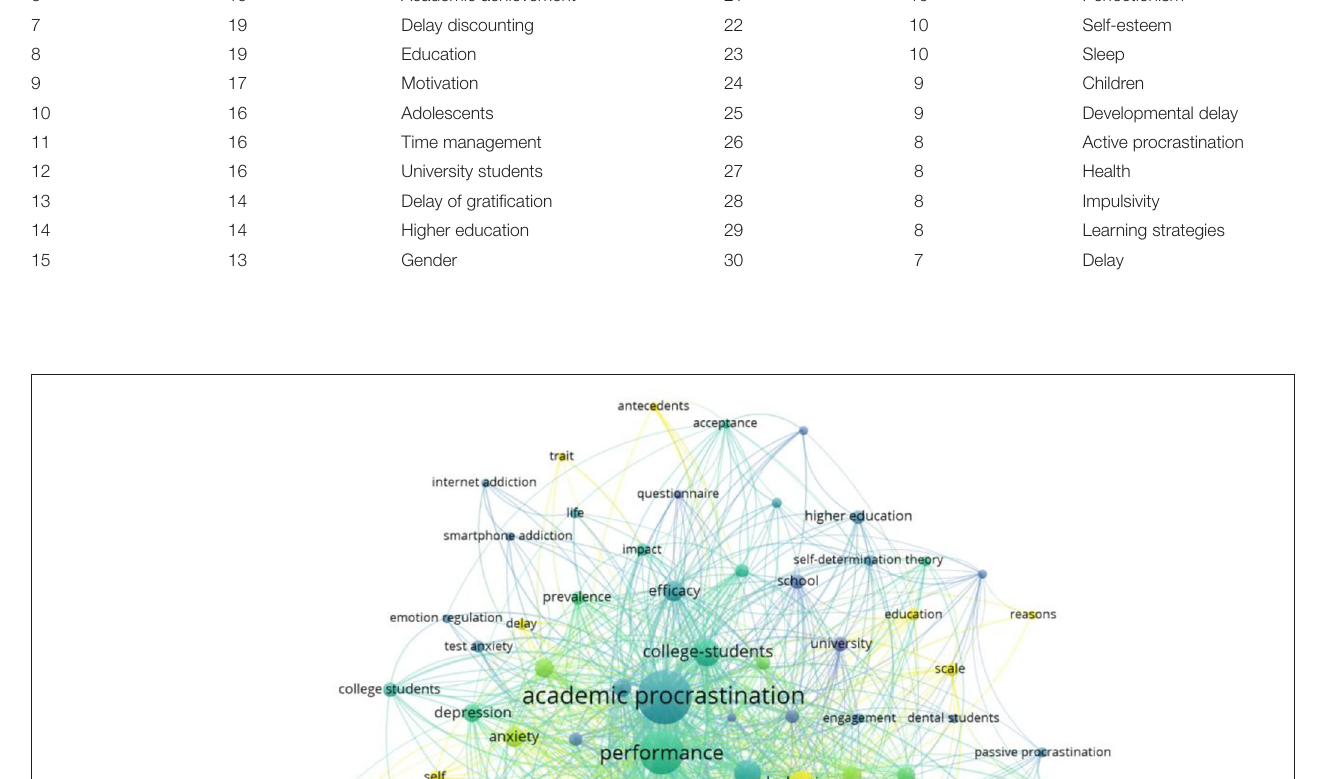
Frontiers in Psychology |